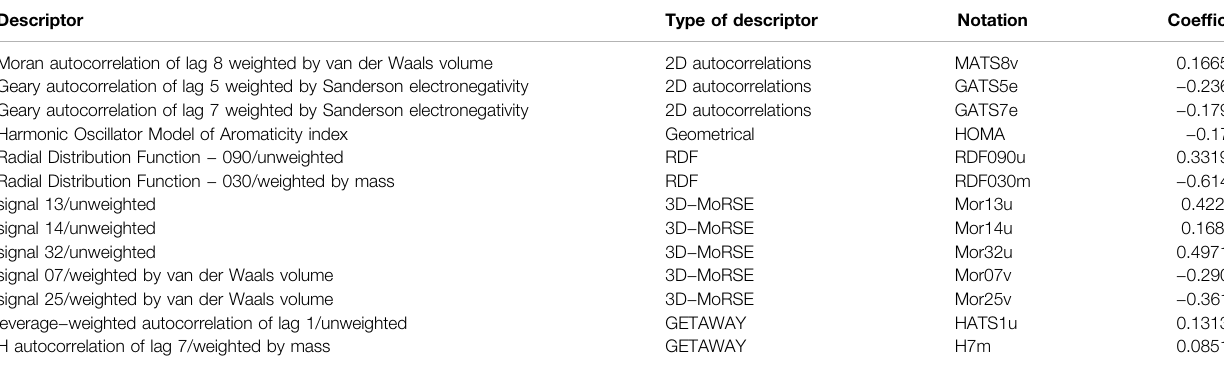
TABLE 5 | Statistical parameters and the name of descriptors in SPA − MLR